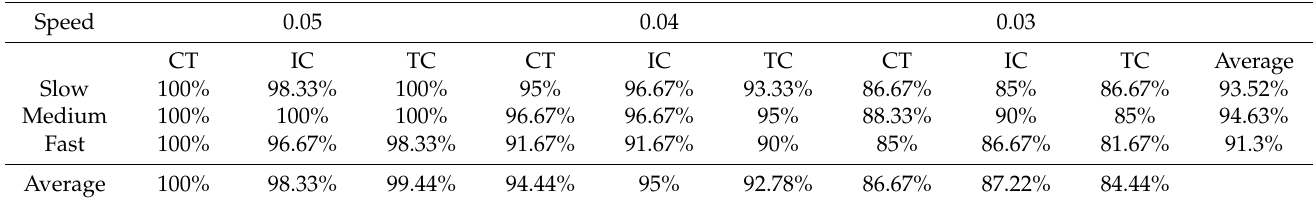
Table 2. The consistency of the two systems under different speeds and maximum tolerance values of the confidence interval.